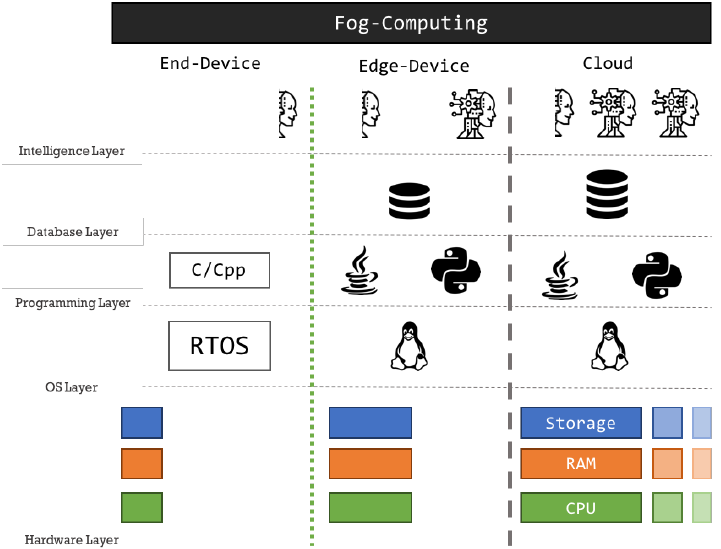
Figure 3. Fog-computing depiction. Contrary to the Cloud-based system (Figure 2), in fog-computing, the machine learning (ML) model is divided into layers, and the bottom layers can be implemented in the edge and end-device. However, they are not stand-alone ML models, and the inference is still Cloud